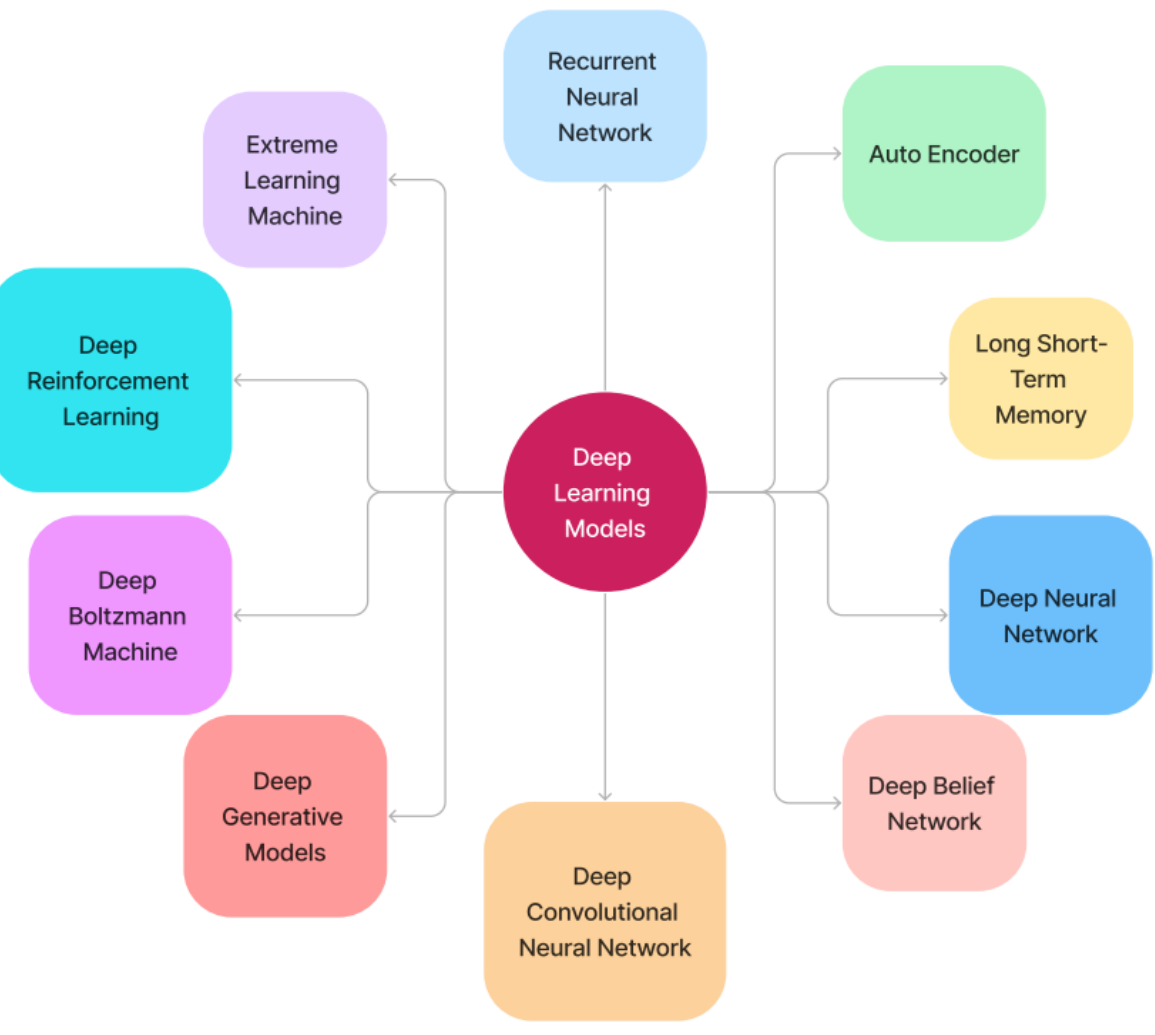
Figure 6. Deep l earning models for Parkinson’s disease diagnosis used in this review . Figure 6. Deep learning models for Parkinson’s disease diagnosis used in this